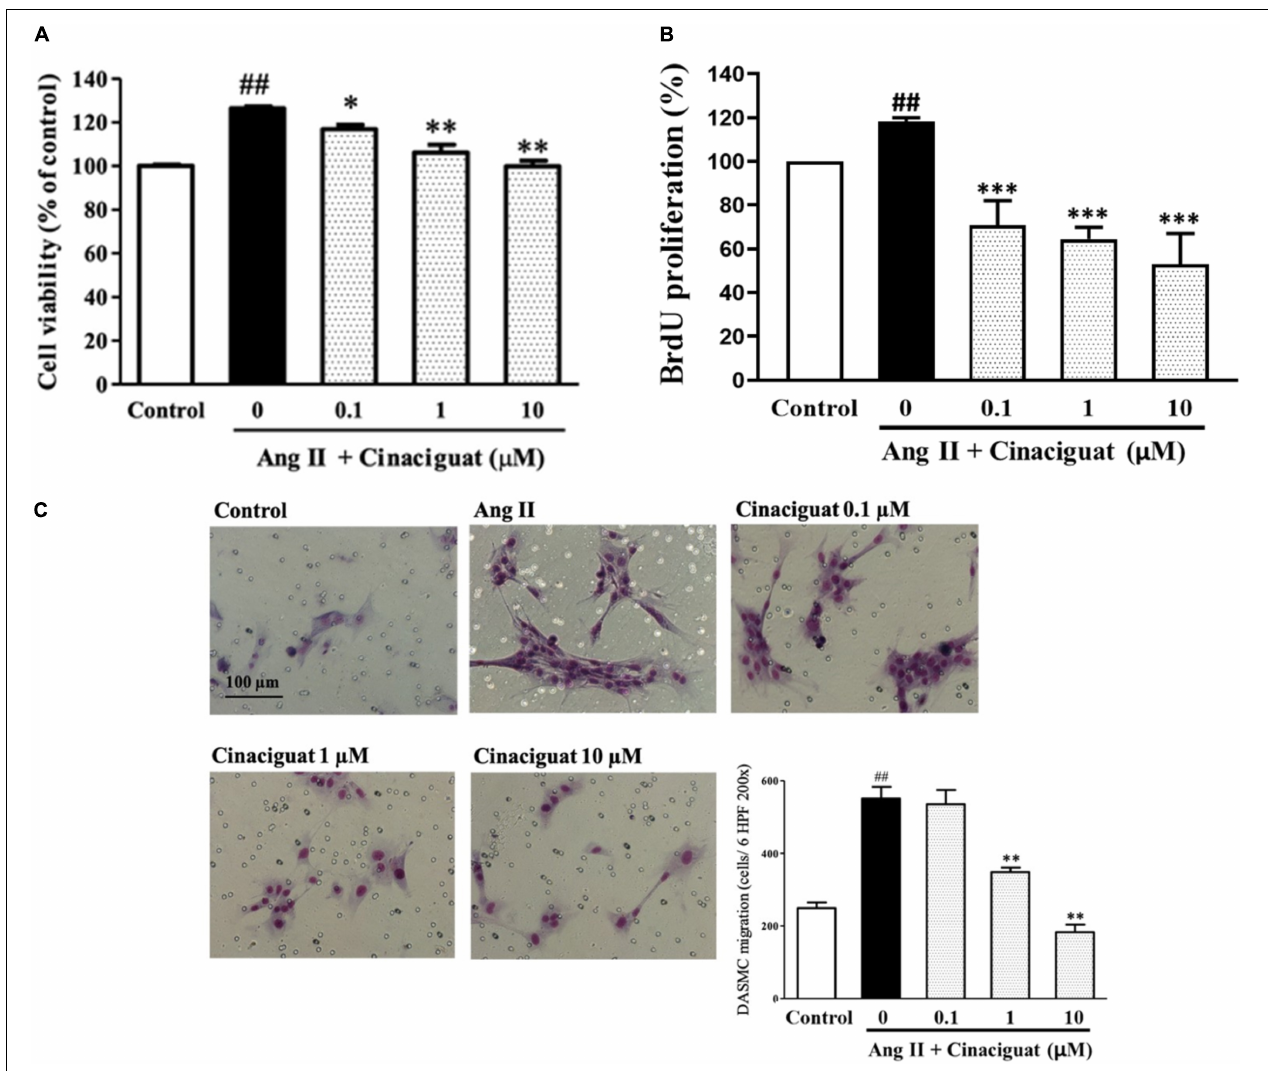
FIGURE 5 | Cinaciguat inhibited Ang II-induced ductus arteriosus smooth muscle cell (DASMC) proliferation and migration. (A) The cell viability was augmented by Ang II after 48 h of incubation. Cinaciguat significantly inhibited Ang II-induced proliferation in a dose dependent manner. (B) BrdU incorporation of DASMCs was increased after incubation with Ang II for 48 h. However, cinaciguat attenuated Ang II-induced BrdU incorporation in a concentration-dependent manner. (C) Cinaciguat significantly inhibited Ang II-induced migration in a dose dependent manner. The photomicrograph showed the Ang II-induced migration of DASMCs from upper to lower chamber. The bar graph shows migration activity assessed by the number of cells observed in six high-power fields. Values represent the mean ± SEM; N = 6. All one-way ANOVA P < 0.0001. ## P < 0.01 vs. control; * P < 0.05, ** P < 0.01, and *** P < 0.001 vs. Ang II alone (magnification 200 ×